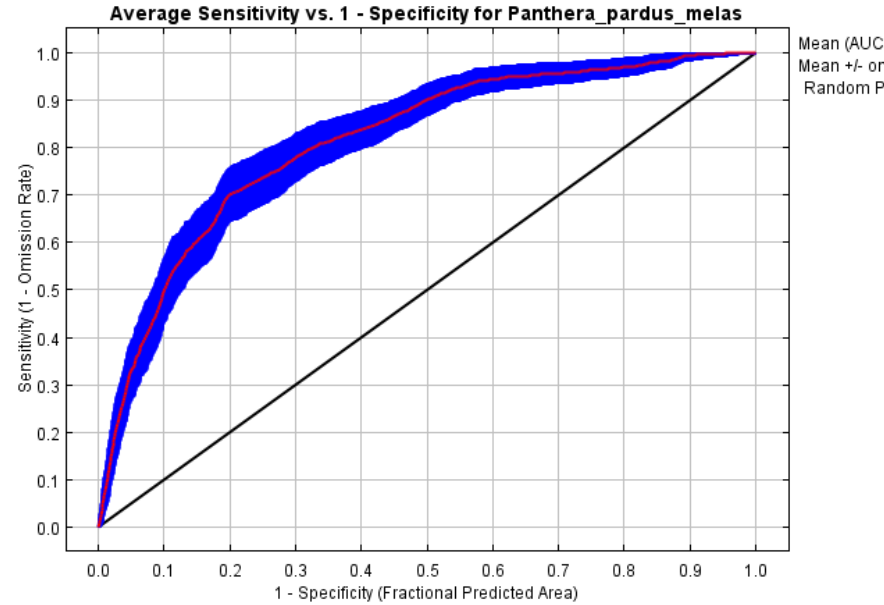
Figure 2. Receiver Operating Characteristic (ROC)